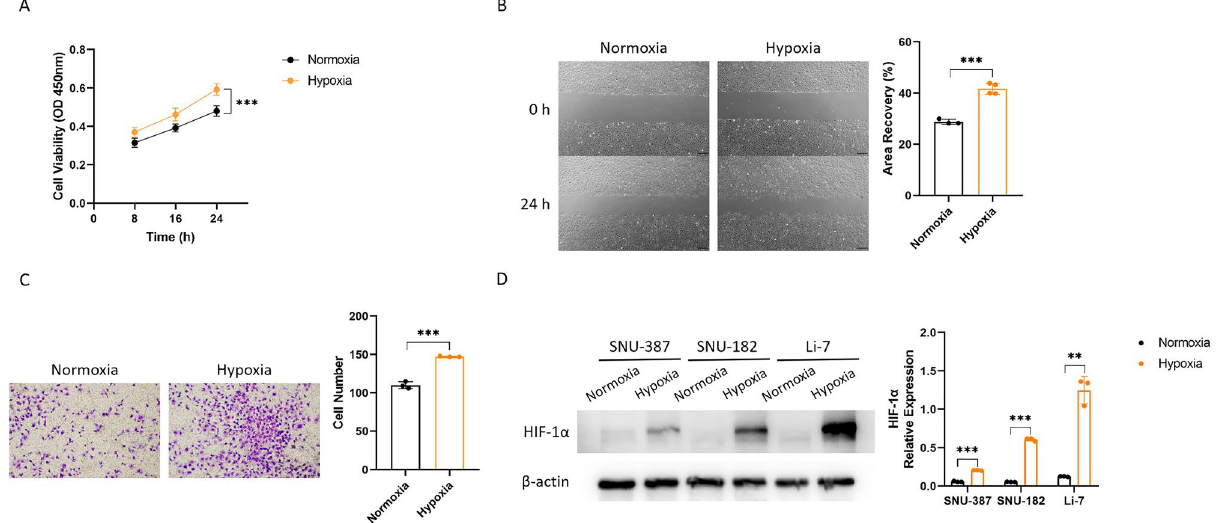
Figure 1. Hypoxia promotes liver cancer cell proliferation, migration, invasion, and the expression of HIF-1α. ( A ) The proliferation ability of liver cancer cells under normoxia and hypoxia by CCK-8 assay (n = 6). ( B ) The migration ability of liver cancer cells under normoxia and hypoxia by wound healing assay. ( C ) The invasion ability of liver cancer cells under normoxia and hypoxia by transwell assay. ( D ) The protein expression levels of HIF-1α in various liver cancer cells under normoxia and hypoxia. The original WB results with markers were shown in Supplementary File 1. The experimental data was represented by mean ± SD from at least three independent experiments. ** P < 0.01, *** P < 0.001.